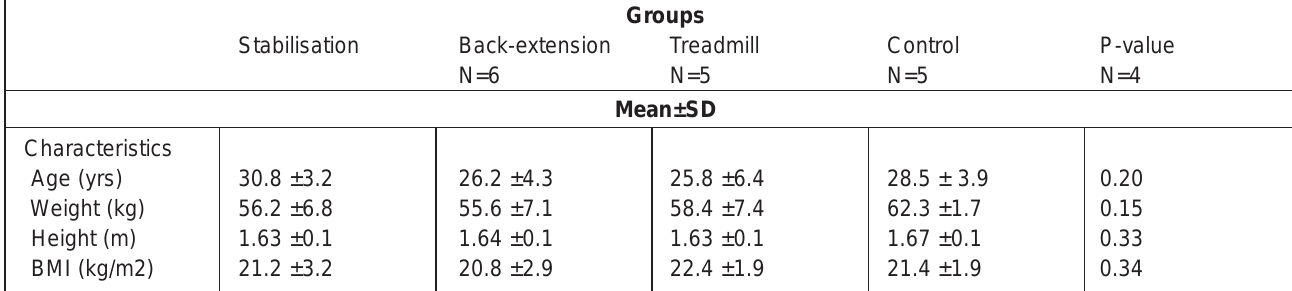
Table 1: Demographic variable of the participants